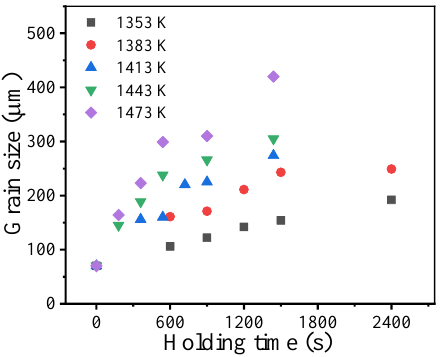
Figure 4. Grain sizes at different holding times and holding temperatures. Table 3. Material parameters related with the prediction of grain size.